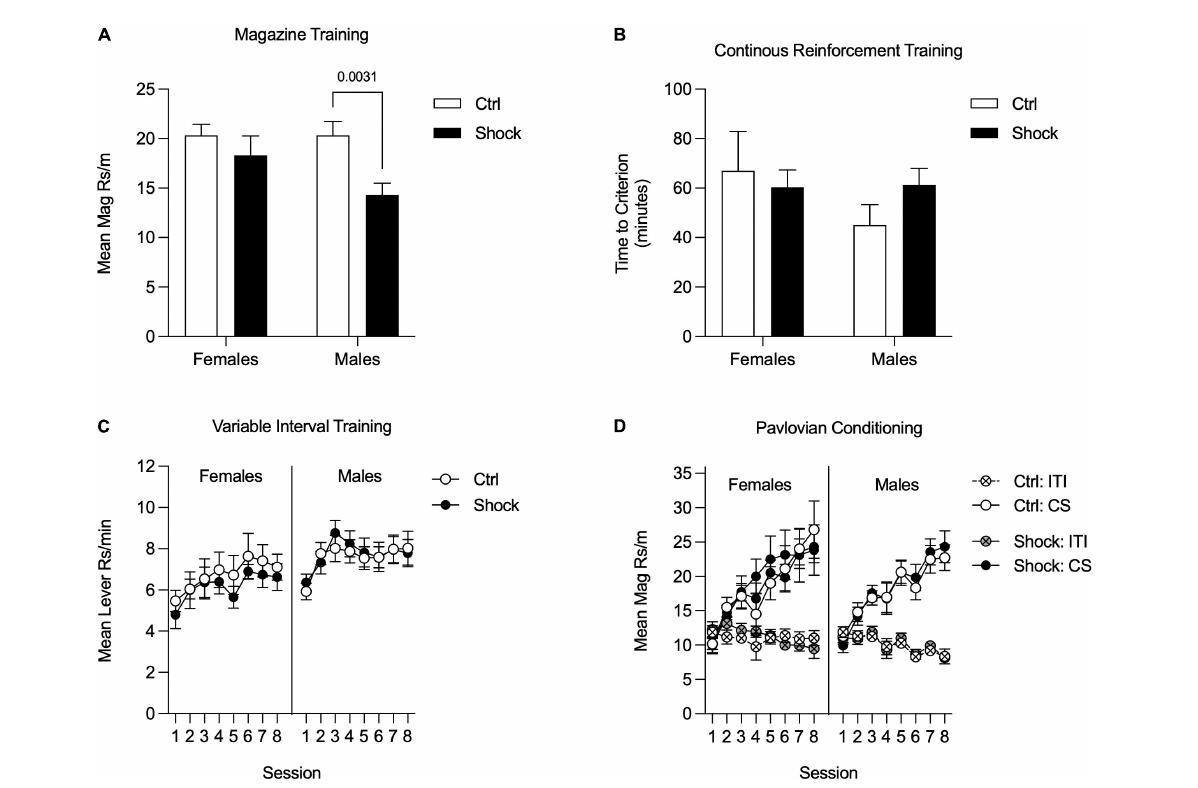
FIGURE5 Appetitive training in Context B in Experiment 2. (A) During magazine training, responding was similar between female Ctrl and Shock groups, whereas in males responding was suppressed in the Shock group relative to the Ctrl group. (B) During CRF training, the time to reach the acquisition criteria did not differ between the Ctrl and Shock groups in either sex and there was no indication of a sex difference in acquisition times. (C) During VI training, instrumental responding increased across sessions, but was not significantly different between the Ctrl and Shock groups in females or in males (Though not shown directly here, responding in Shock groups was lower in females than males throughout training; there were no sex differences in responding in the Ctrl groups). (D) During Pavlovian conditioning, magazine responding during CS+ presentations increased across sessions without any differences between the Ctrl and Shock groups and no differences or interactions with sex. Magazine responding during the ITI and CS- did not increase across session and there were not differences across groups.